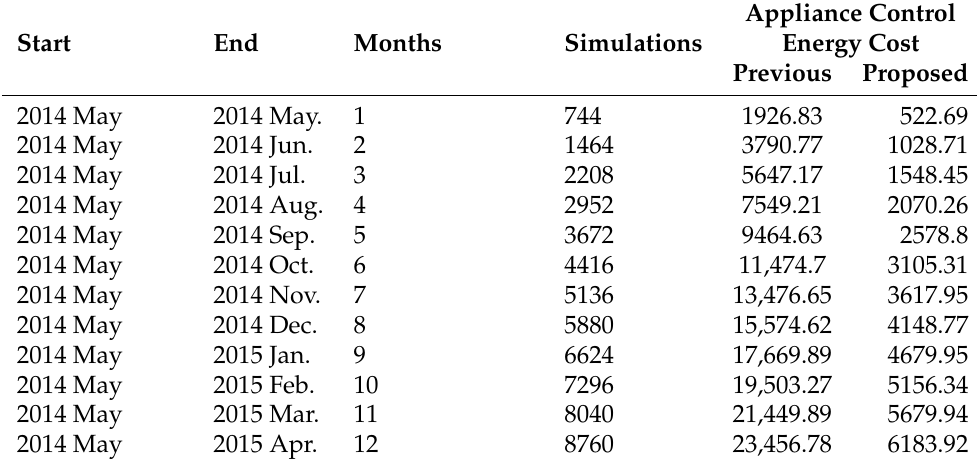
Table 13. Energy-cost comparison when increasing the number of months.